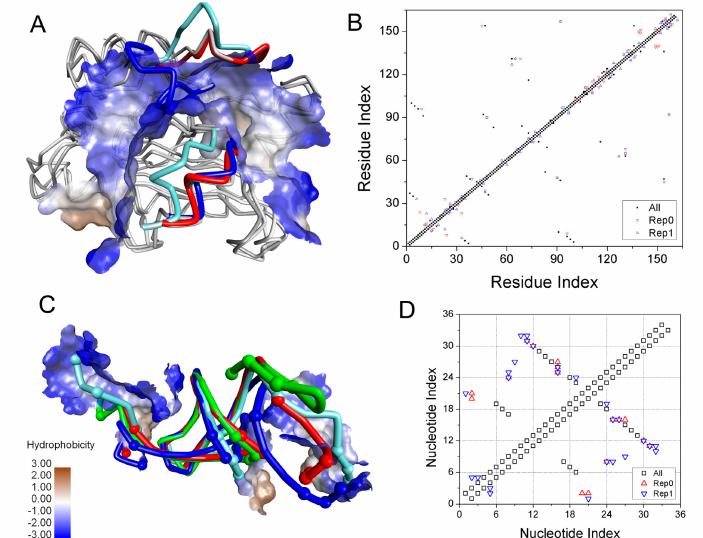
Figure 6. Superimposition of crystallographic structure and the representative structures from the clustering analysis for ( A ) apo-ToxN and ( C ) apo-ToxI. The interaction surfaces between ToxN and ToxI are shown in hydrophobic surface. All the structures are shown in tube representation. The different colors represent different conformations. The crystallographic structures are shown in pale cyan color. The nucleotides with different conformation in apo-ToxI are shown with an atom in a ball representation representing a nucleotide. Contact map based on the representative structures of clusters representative 0 (Rep0) and Rep1 for ( B ) ToxN and ( D ) ToxI Black squares represent the contacts that exist in both Rep0 and